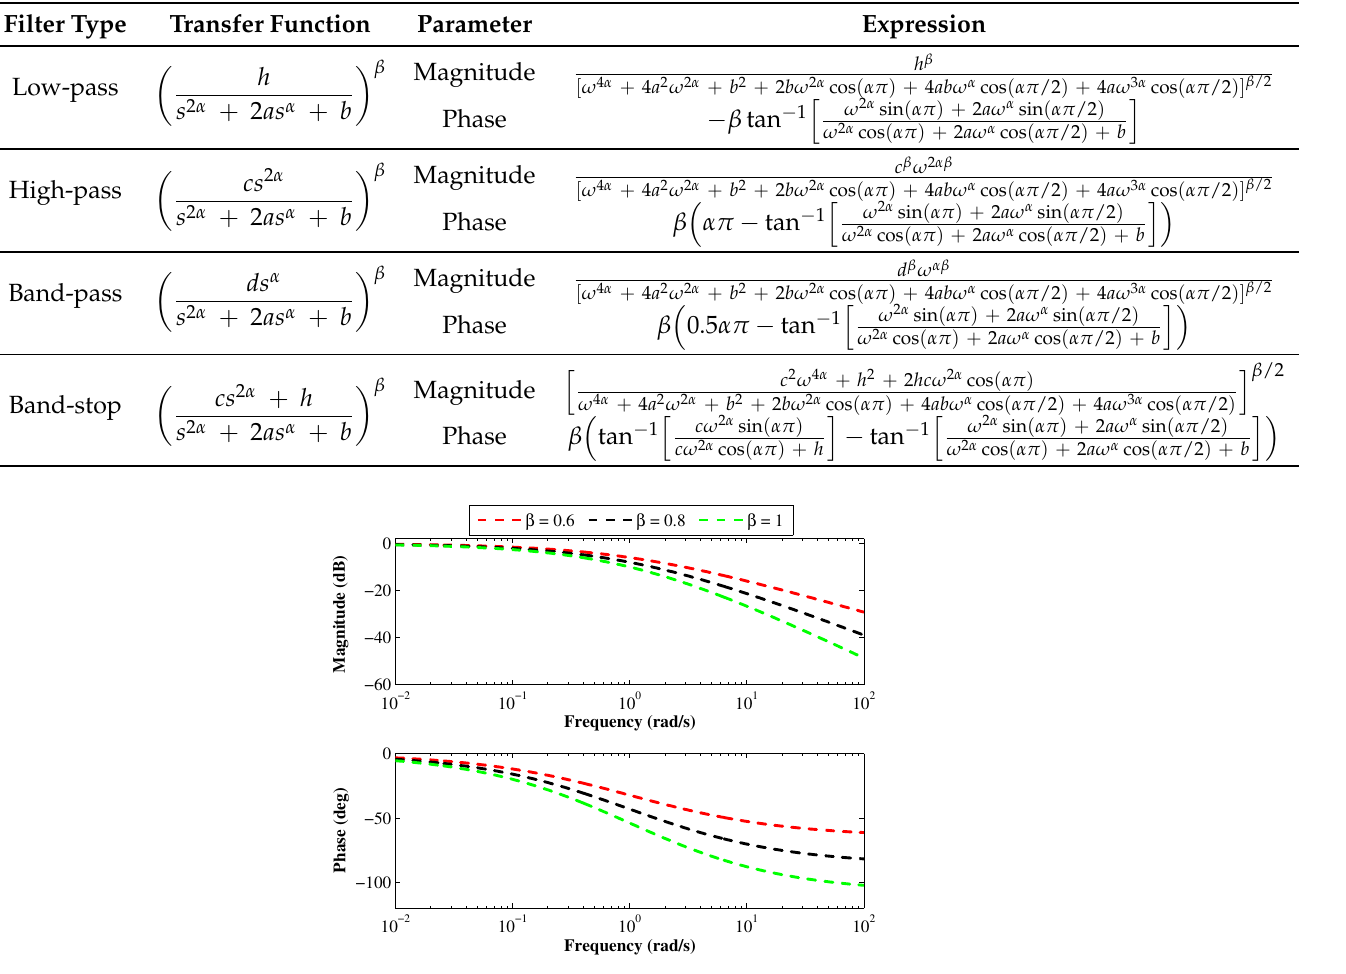
Figure 1. Magnitude and phase responses of the theoretical FLPF for different values of β with α =